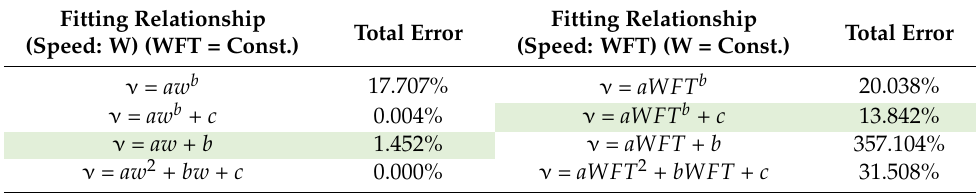
Table 3. Tested Fitting relationships for speed versus W and WFT.